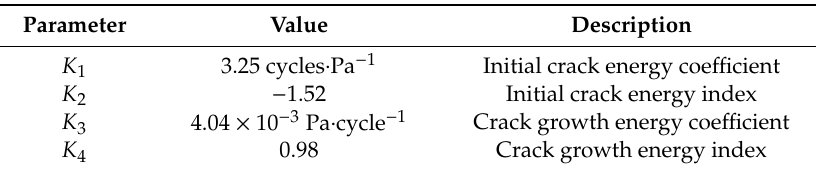
Table 1. Material failure parameters.